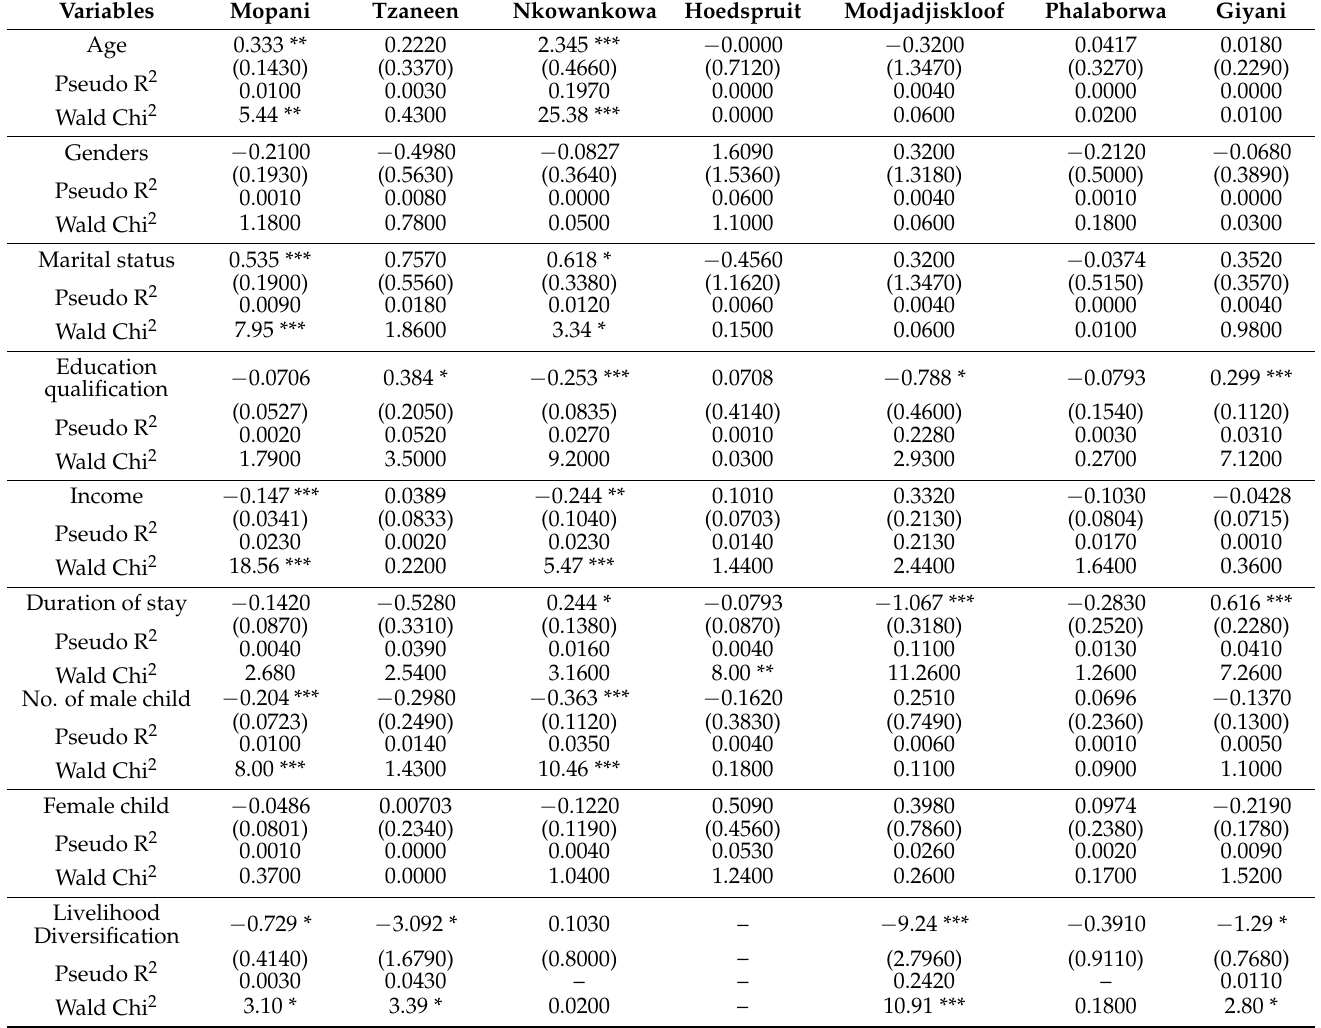
Table 4. The summarized regression results socioeconomic and HVI